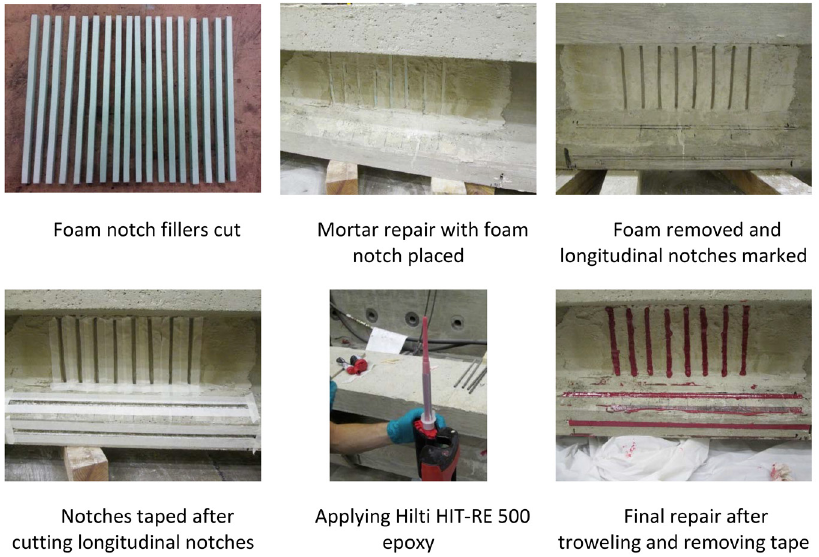
Figure 6. Example of the FRP NSM repair process [28].